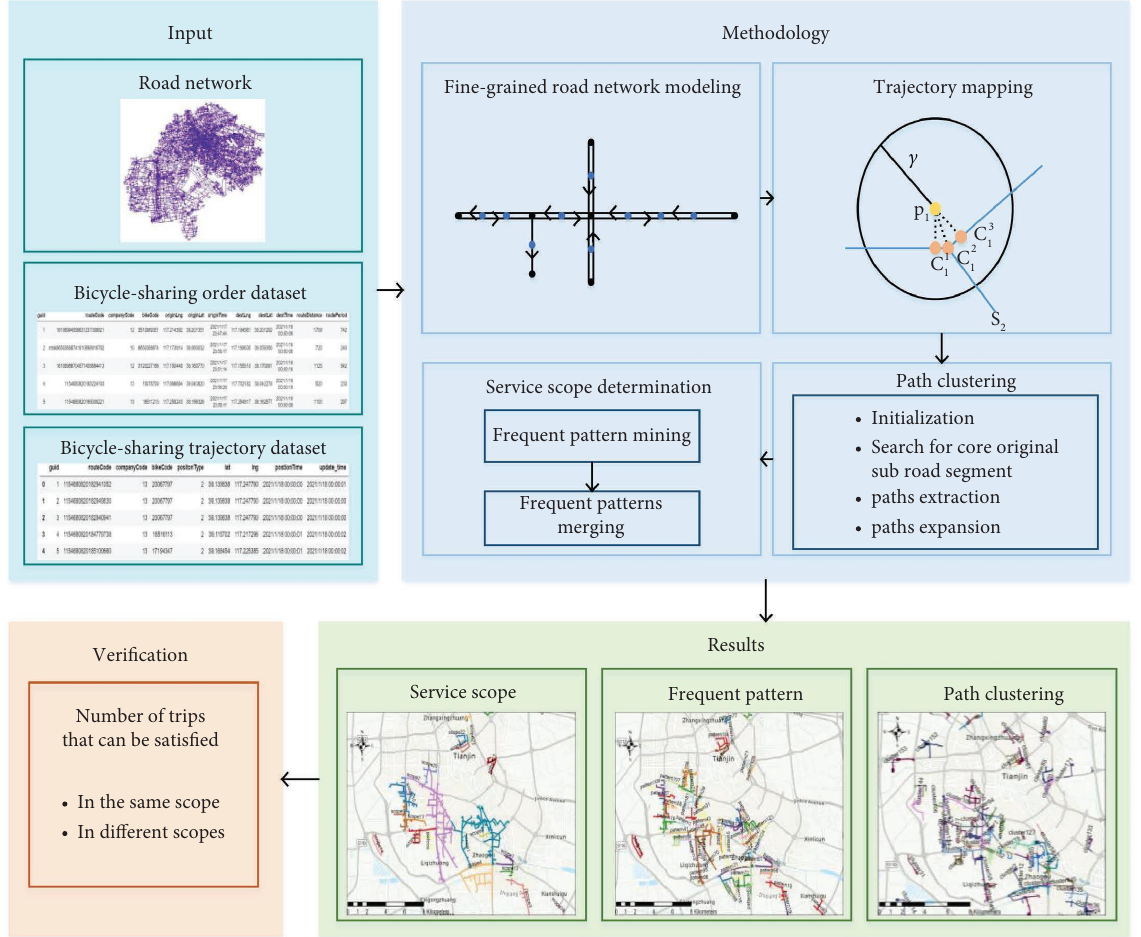
Figure 1: Te research framework of the methodology.